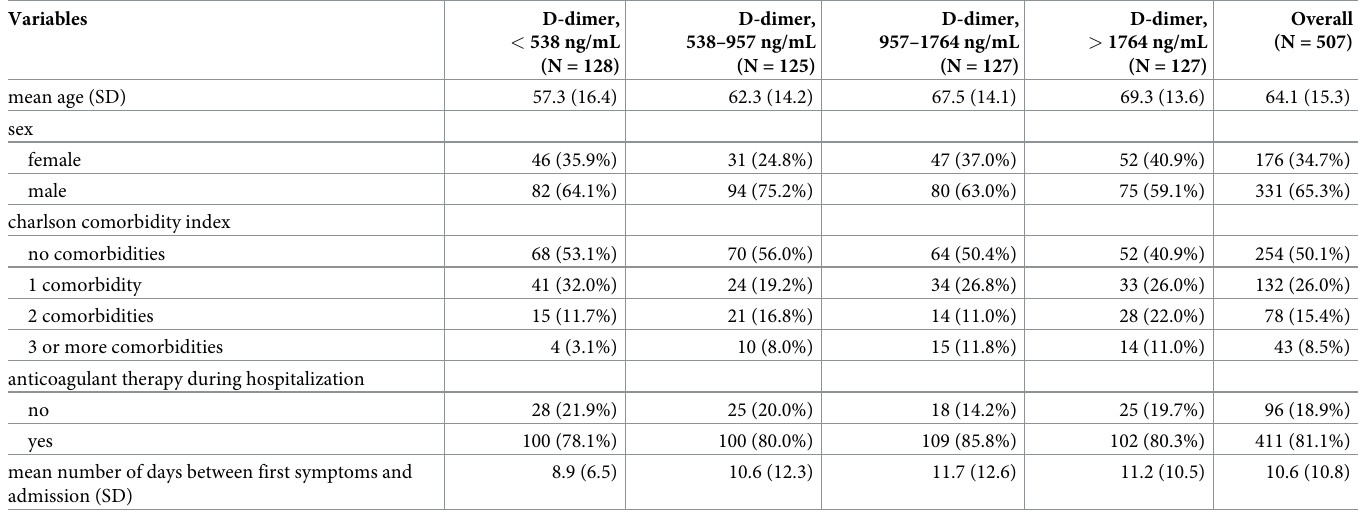
Table 1. Baseline characteristics of COVID-19 patients hospitalized in the region of Lombardy, Italy, during the first COVID-19 wave (Feb-May 2020).